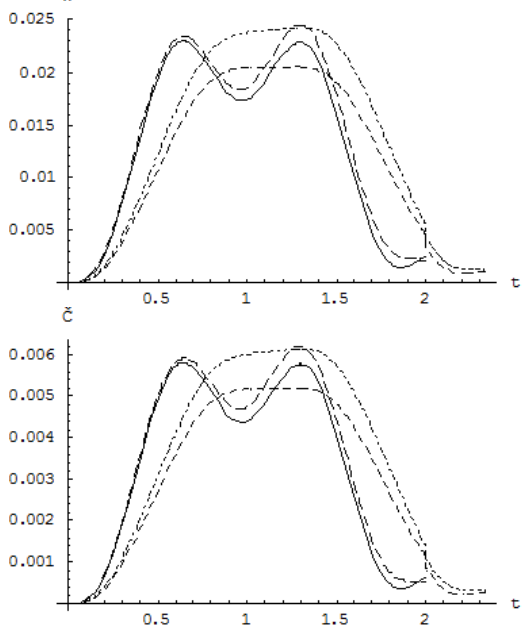
Figure 37: The vertical-torsional motion of the middle of the bridge, for R = 100 m, d = 5 m, e H = 3.00 m, e V = 1.20 m, υ = 30 m/s, un- der the action of a Damped load ( __ ), Simple load ( _ _ ), Damped vehicle (- - - ), Simple vehicle (. . . .).